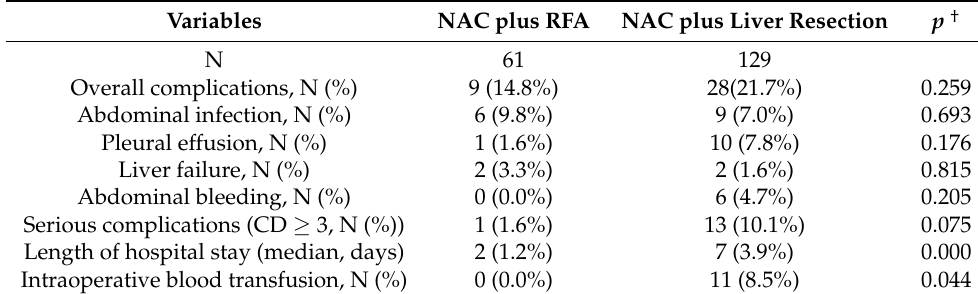
Table 3. Perioperative